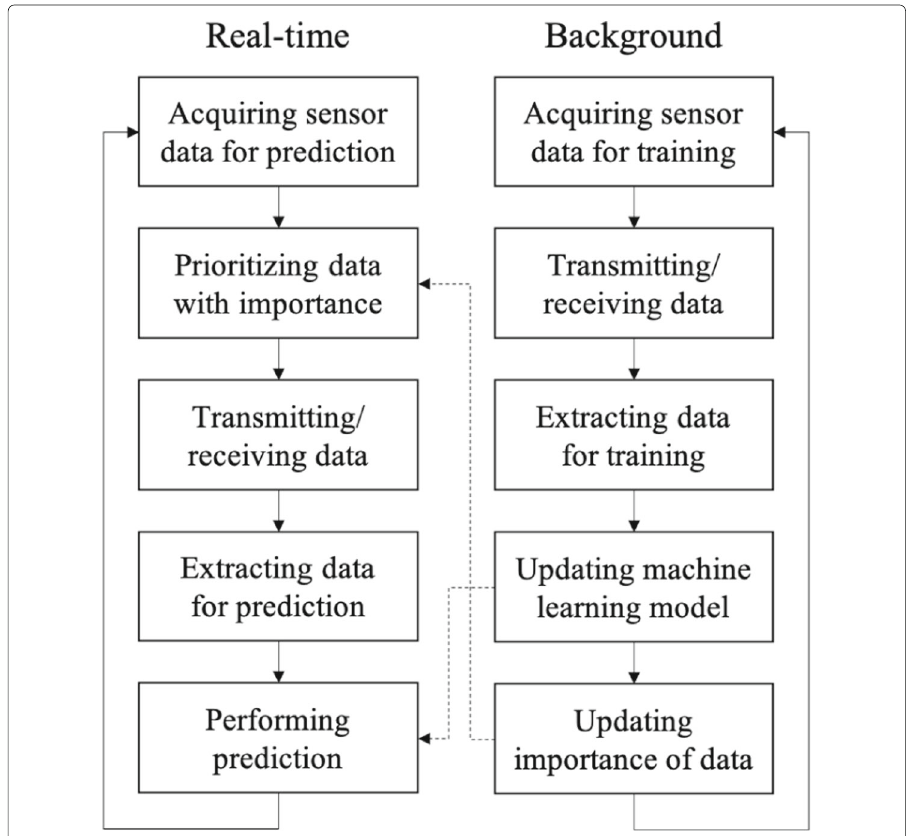
Fig. 3 Process flow in proposed framework. Solid and broken lines indicate main process flow and information update, respectively